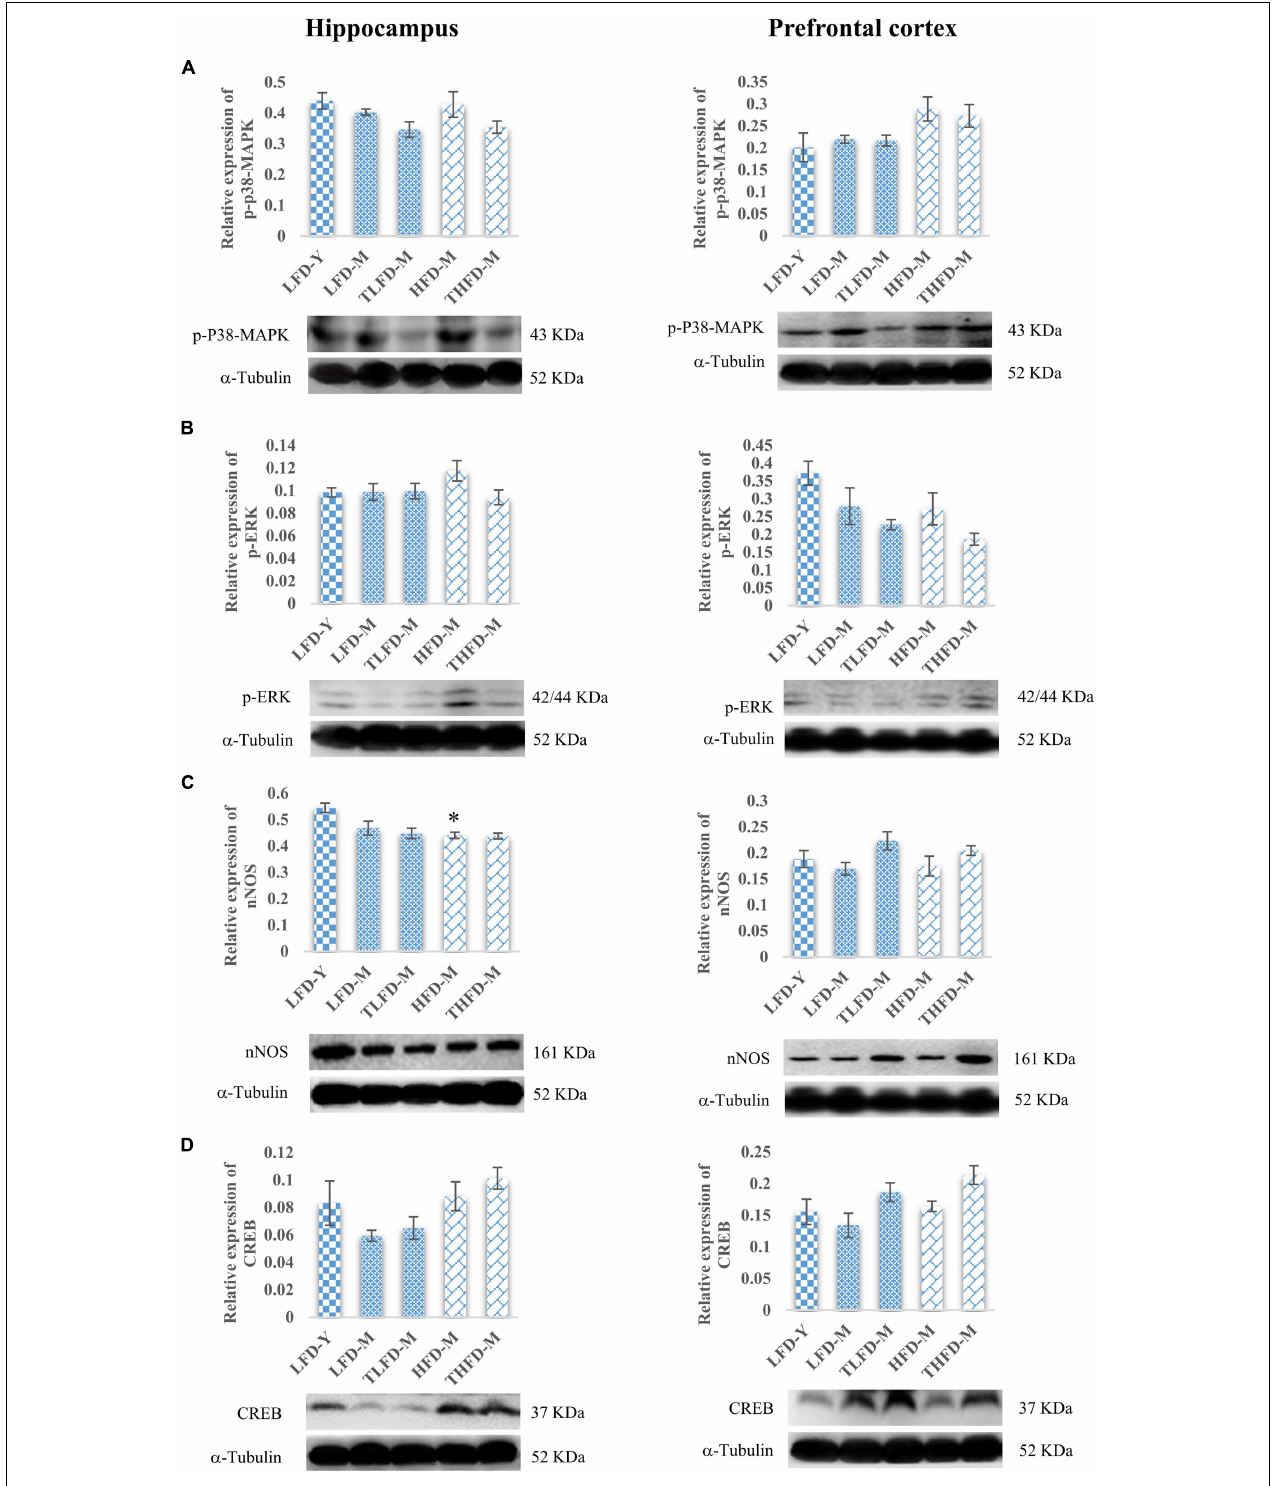
FIGURE 6 | Tinospora cordifolia stem powder (TCP) supplementation ameliorated the expression of target proteins associated with synaptic plasticity p38-MAPK/ERK pathway in middle-aged acyclic female rats. Histogram representing analysis of fold change in expression of (A) p-P38-MAPK, (B) p-ERK, (C) nNOS, and (D) CREB in the hippocampus (left panel) and the prefrontal cortex (PFC) (right panel) regions of the brain. Values are presented as mean ± SEM. ∗ p ≤ 0.05 LFD-Y vs. HFD-M.